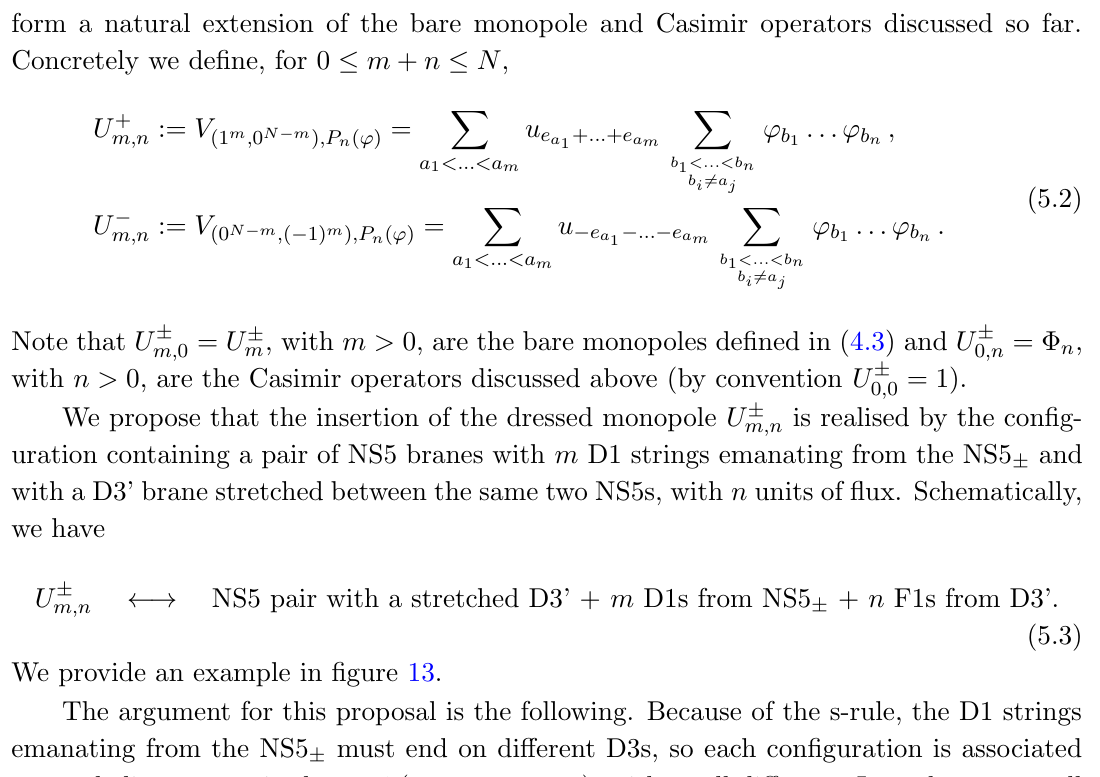
Figure 13 . Brane setup realising the insertion of the dressed monopole U + nating from the NS5 + and two F1s emanating from the D3’. Only one pattern of strings is shown here, with strings (D1 and F1) ending on di(cid:11)erent